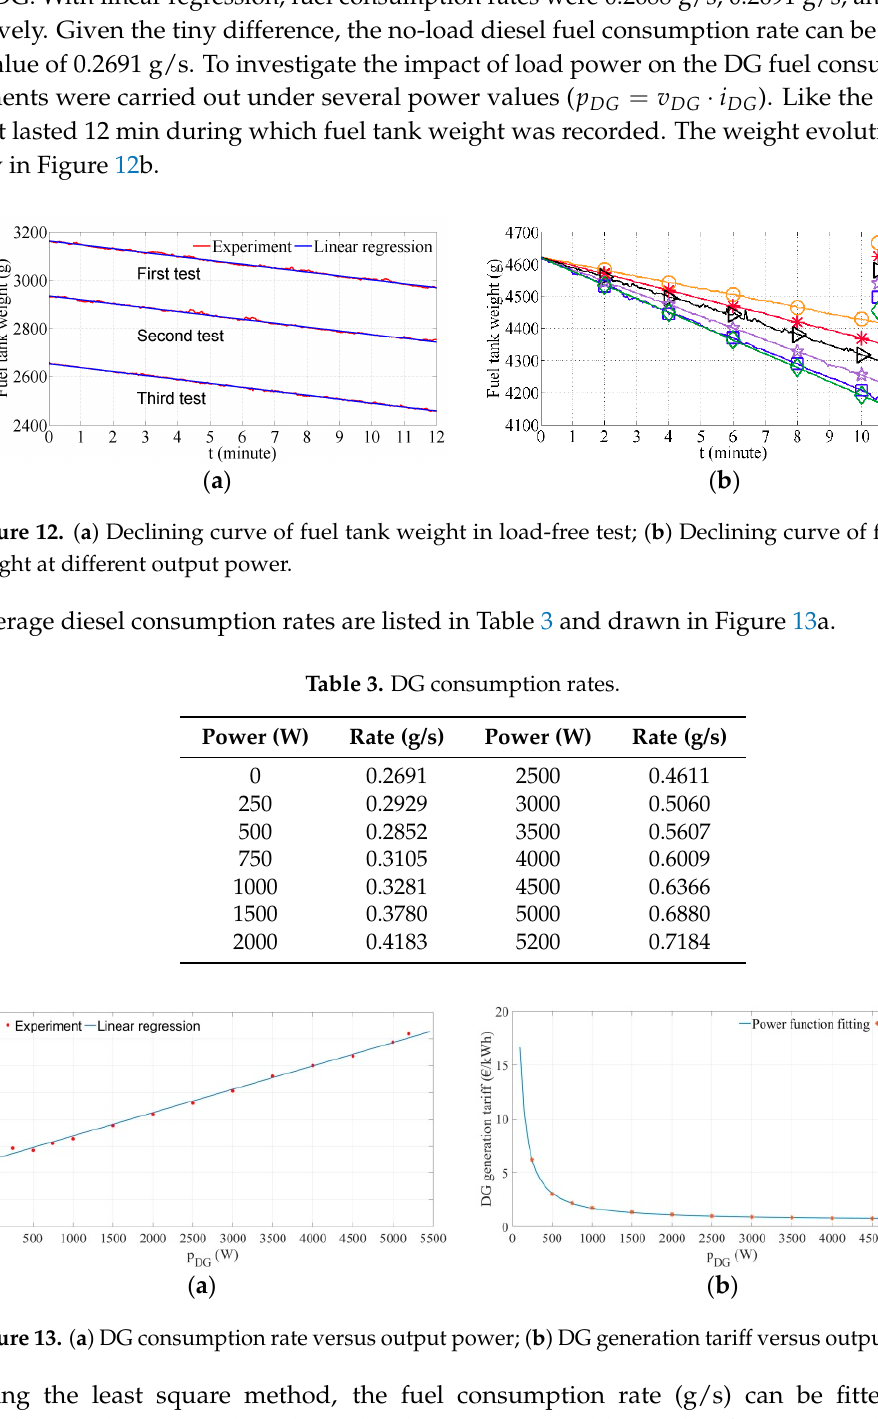
Figure 13. ( a ) DG consumption rate versus output power; ( b ) DG generation tariff versus output power.